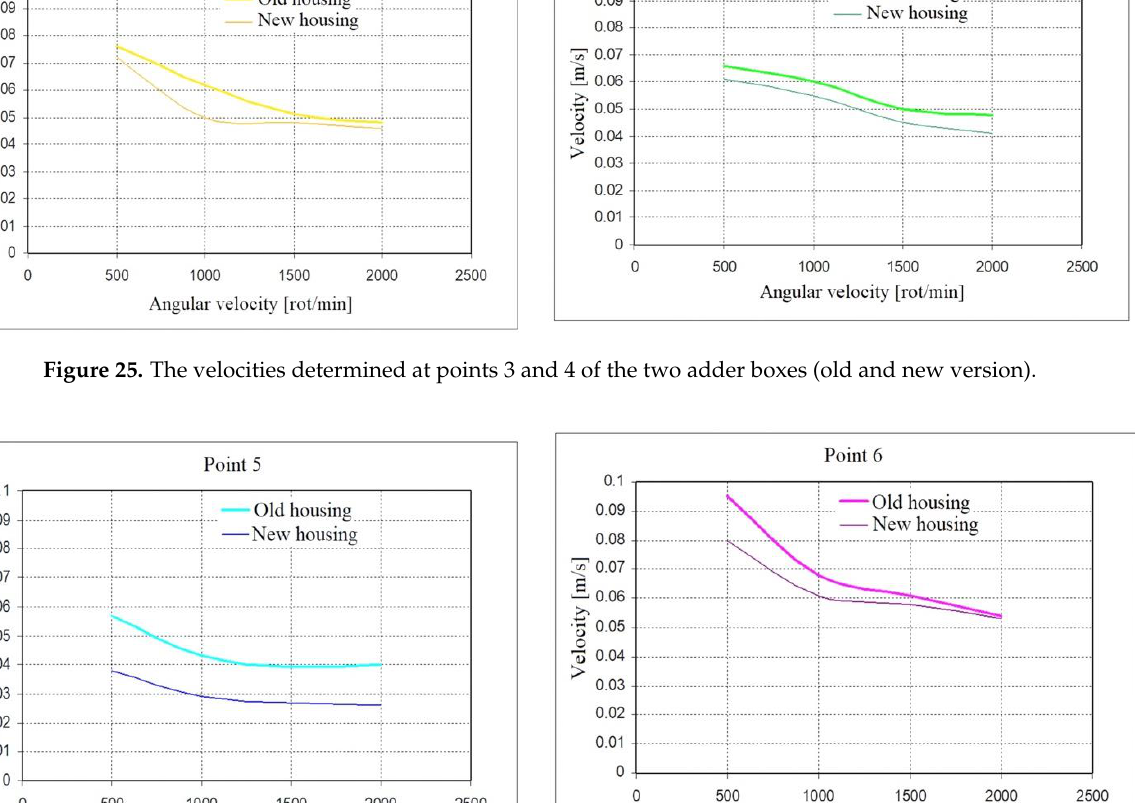
Figure 26. The velocities determined at points 5 and 6 of the two adder boxes (old and new version).